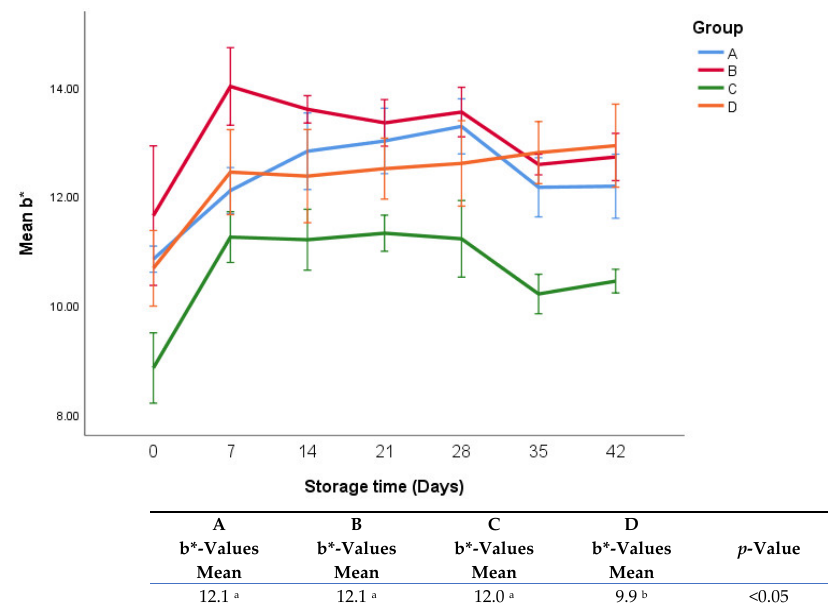
Figure 8. b*-values of fresh oregano at refrigerated temperature 4 °C during storage period (42 days). The significant differences ( p < 0.05) between means are indicated in different letters in the same row. The effect of treatments was pooled to consider the whole storage period and the means were separated by Duncan test. It was found that there were no significant differences in L*-values between group A and D. Group C exhibited significantly lower L*-values than the other groups. There was a drop in L*-values in the first two weeks of storage in all groups.